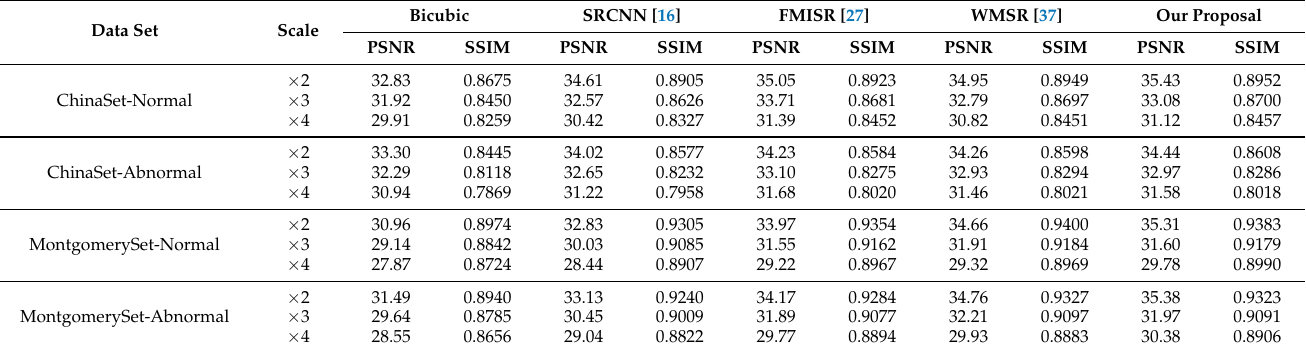
Table 2. Quantitative evaluation results of the different methods with PSNR(dB) and SSIM. Data